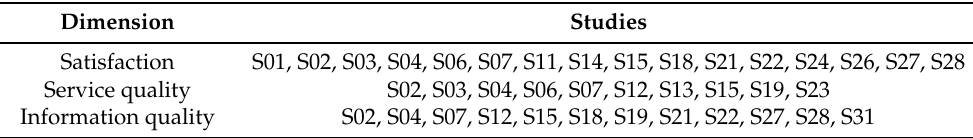
Table 8. Evaluation dimensions and their respective studies. Dimension